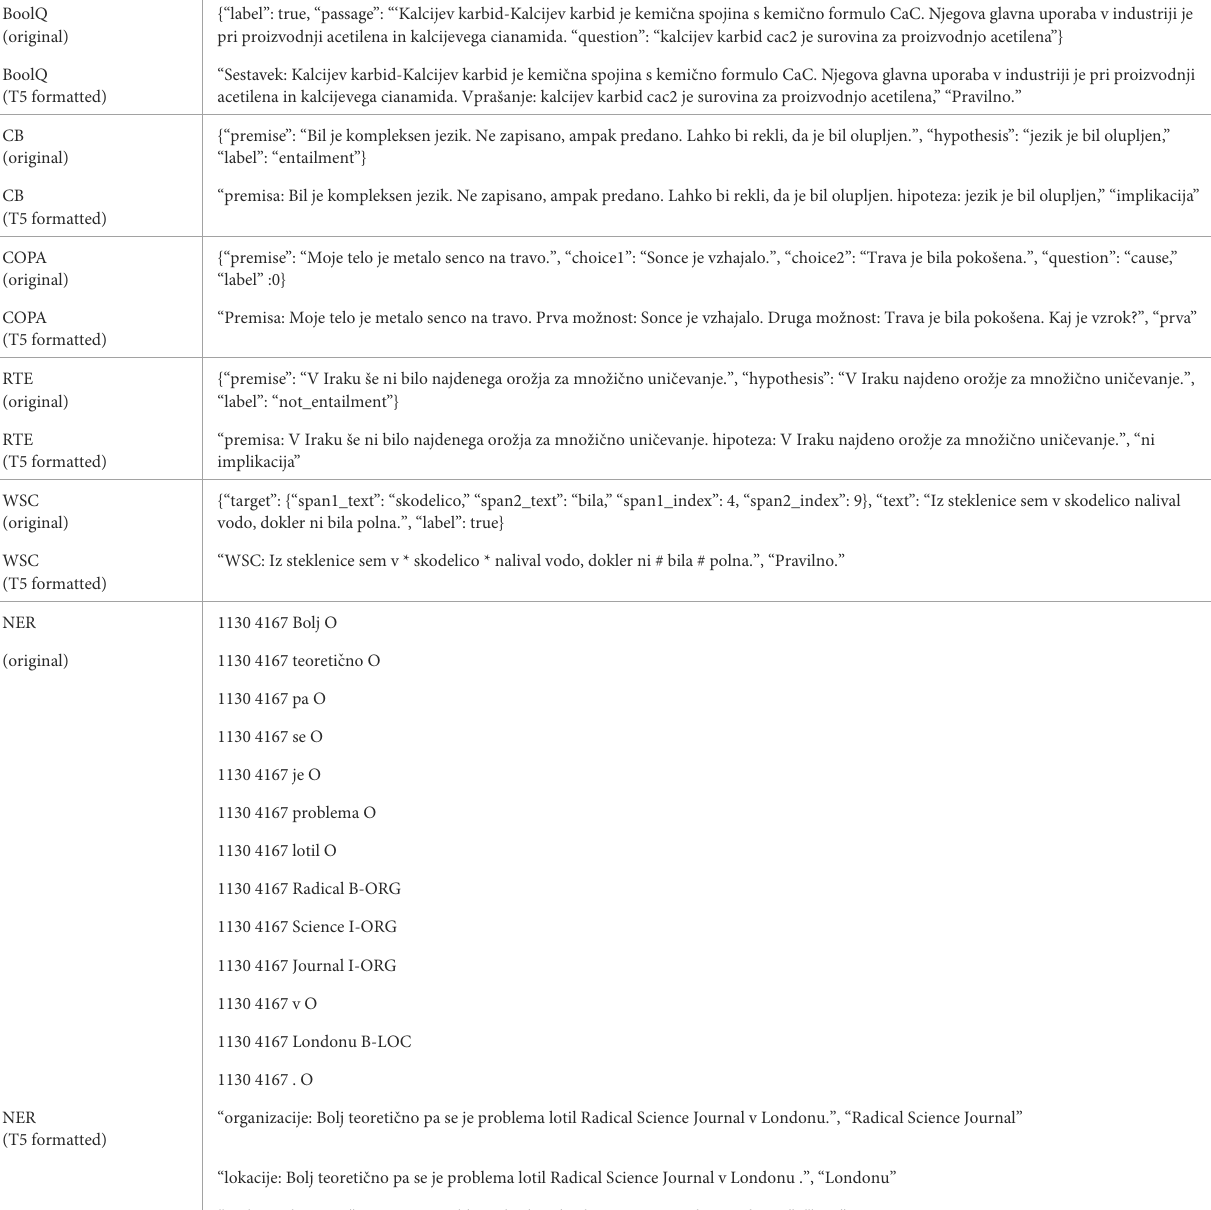
TABLE 2 Original examples and T5 formatted versions for each of the SuperGLUE tasks and the NER